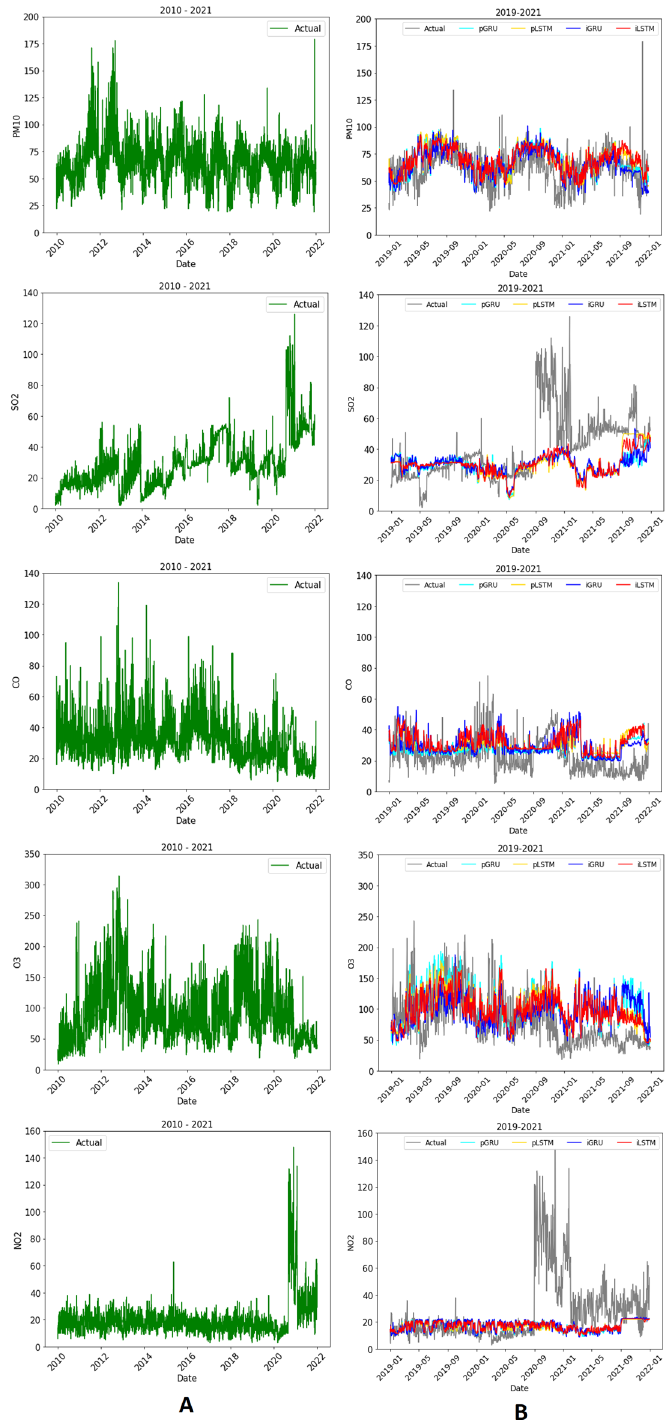
Figure 4. The actual data ( A ) and forecasting ( B ) of AQI in